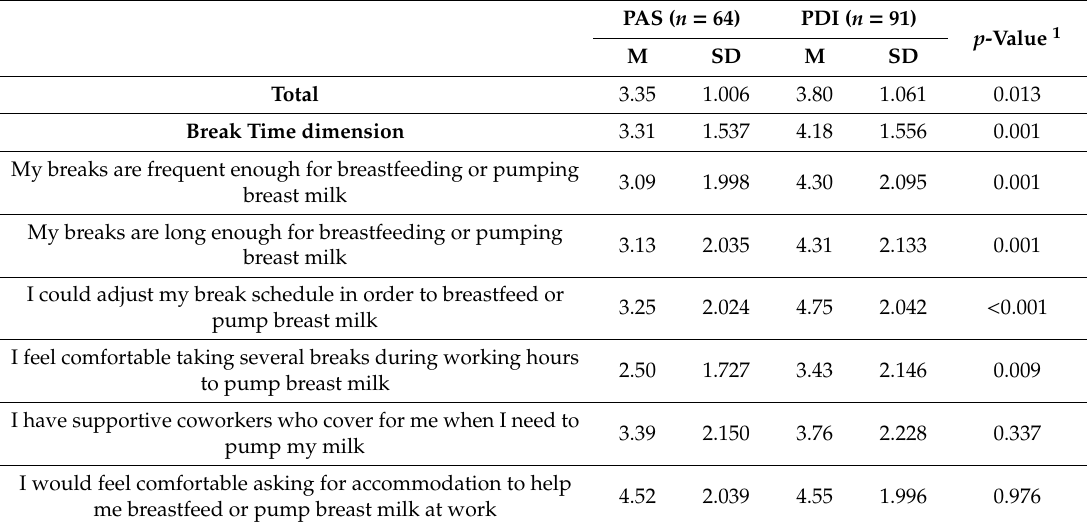
Table 3. Results obtained with the Workplace Breastfeeding Support Scale. Comparison of occupational situation ( n =